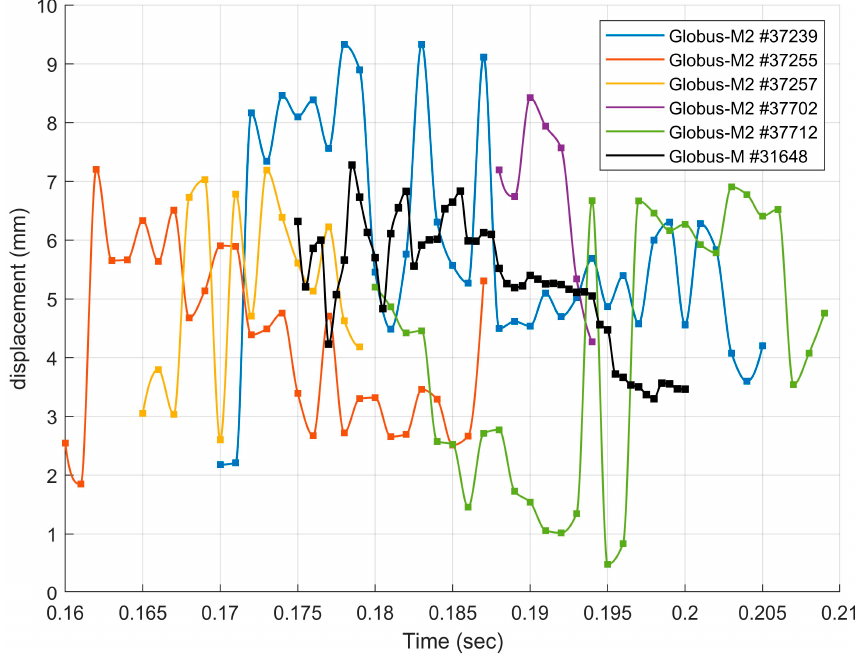
Figure 13. Dynamic of the lower estimation of the reachability region of plasma shape changes dur- ing different shots in spherical tokamak Globus-M/M2.